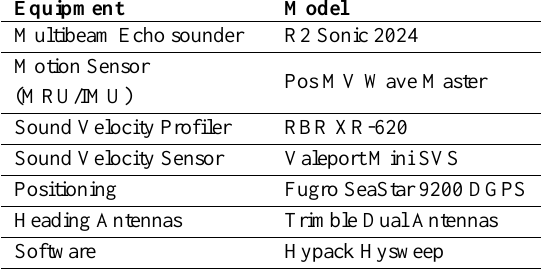
Table 1: List of the survey equipment